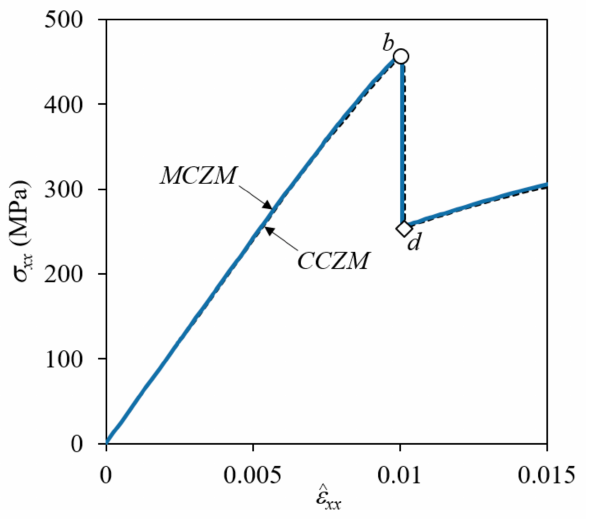
Figure 9. Comparison of nominal stress-strain curves for symmetric plain weave unit cell ( x = λ w